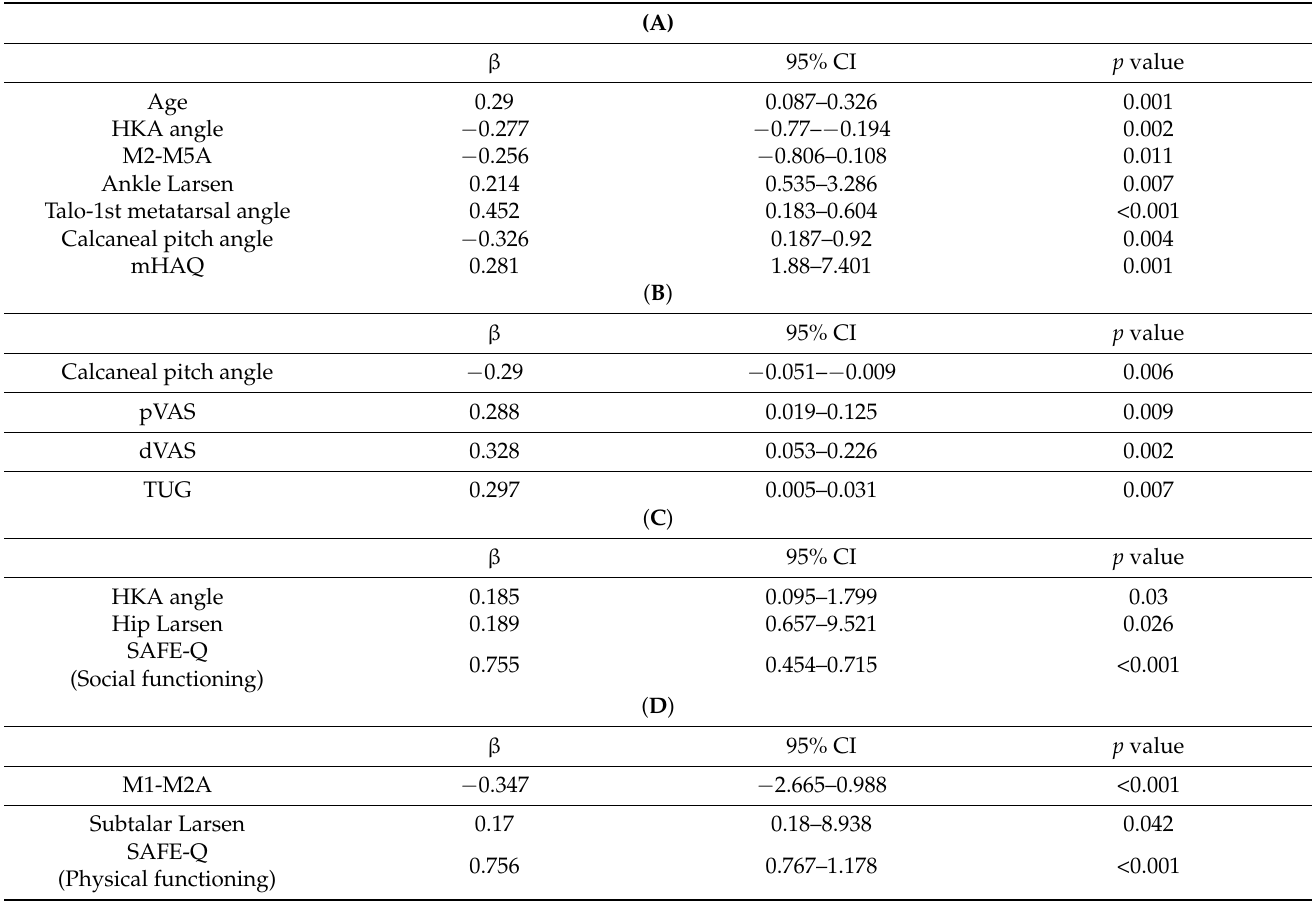
Table 4. Correlation coefficients between physical activity/ADL and other parameters on multivariable linear regression analysis. ( A ) Correlation coefficients between TUG time and other parameters. ( B ) Correlation coefficients between mHAQ and other parameters. ( C ) Correlation coefficients between SAFE-Q (Physical functioning) and other parameters. ( D ) Correlation coefficients between SAFE-Q (Social functioning) and other